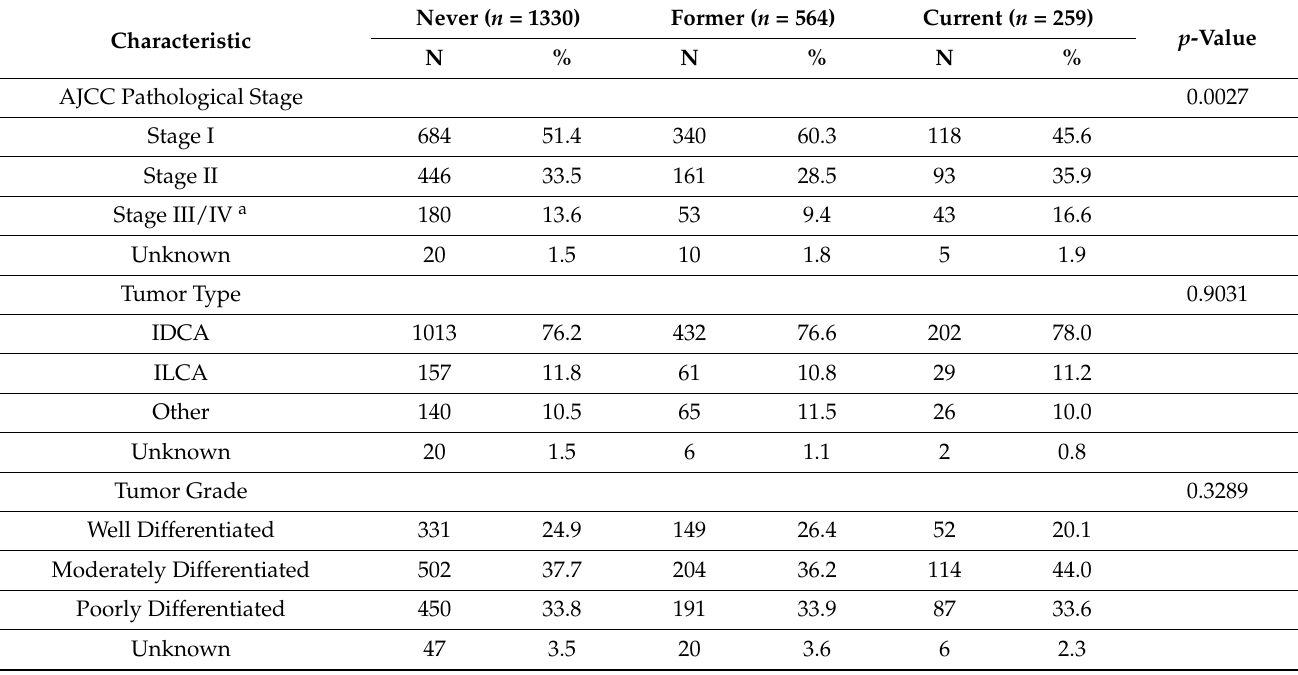
Table 2. Clinicopathological characteristics for 2153 women with breast cancer enrolled in the